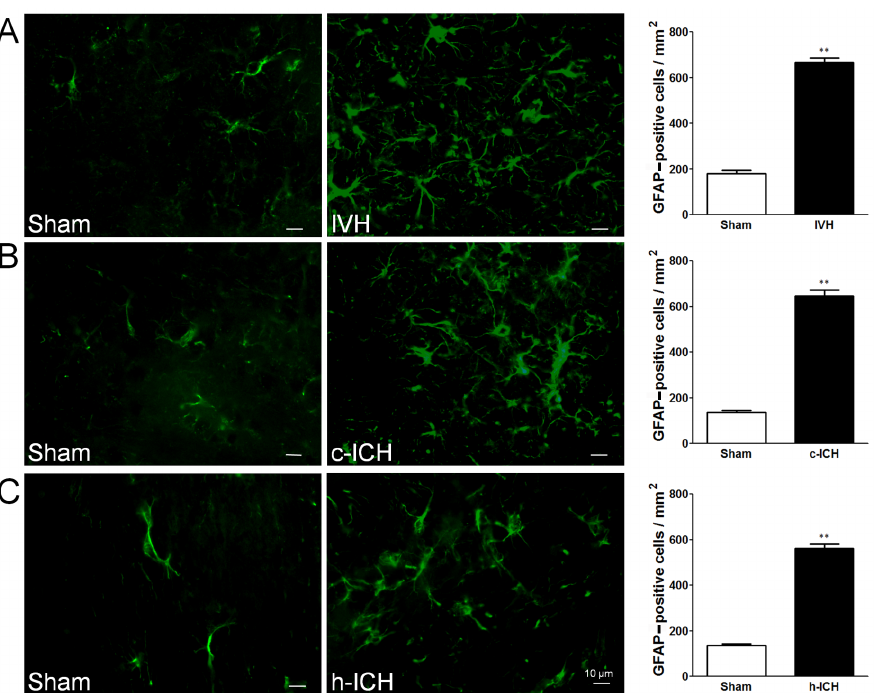
Figure 4. Astrocyte activation is elevated 72 h after intracerebral hemorrhage (ICH) in ventricle, cortex, and hippocampus. Staining for GFAP revealed reactive astrocytes in the brain regions around the lateral ventricles 72 h after intraventricular hemorrhage (IVH; A) and in the perihematomal regions of the frontal cortex (B) and hippocampus (C) 72 h after cerebral ICH (c-ICH) and hippocampal ICH (h-ICH), respectively. Quantification analysis showed that the number of reactive astrocytes in the IVH, c-ICH, and h-ICH groups was significantly greater than that in the respective sham groups (n=5 mice per group). Scale bar =10 m m. Values are means 6 SD; ** p , 0.01, t-test.